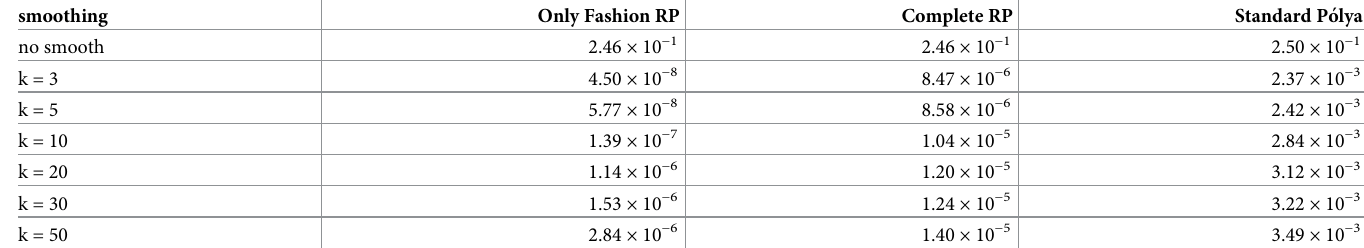
Table 25. “Covid” ( T = 0.5, entire, D = 3 0 , slots = days): MSE for different levels of smoothing. smoothing